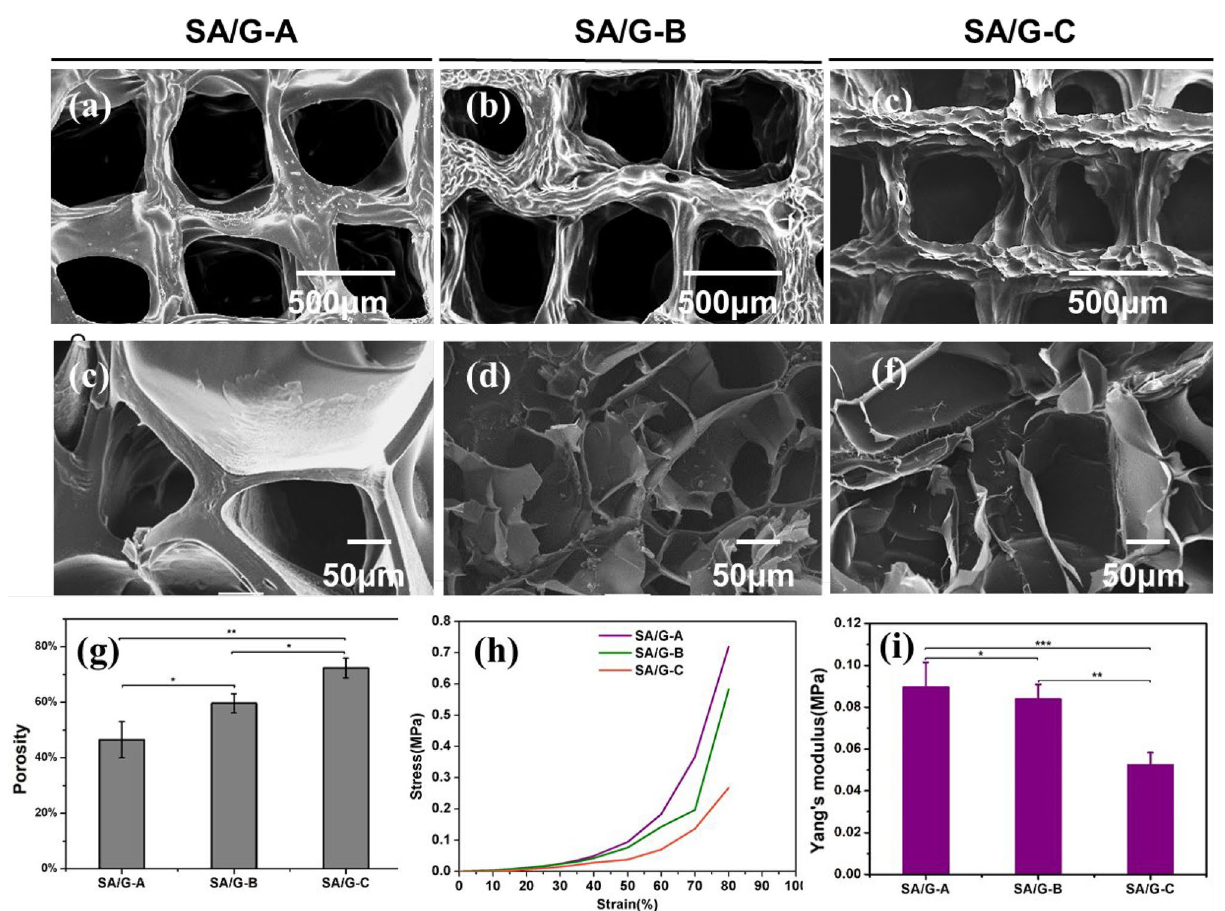
Figure 4. Physical properties of scaffolds. ( a – f ) Photographs taken with SEM showed multi-scale pore size, ( g ) Porosity of scaffolds, ( h ) compressive stress–strain curve, and ( i ) Young’s Modulus of printed scaffolds measured after crosslinking by CaCl 2 . All data are displayed as mean ± SD. ***indicates p < 0.001, **indicates p < 0.01, *indicates p < 0.05, analysed via Welch’s t